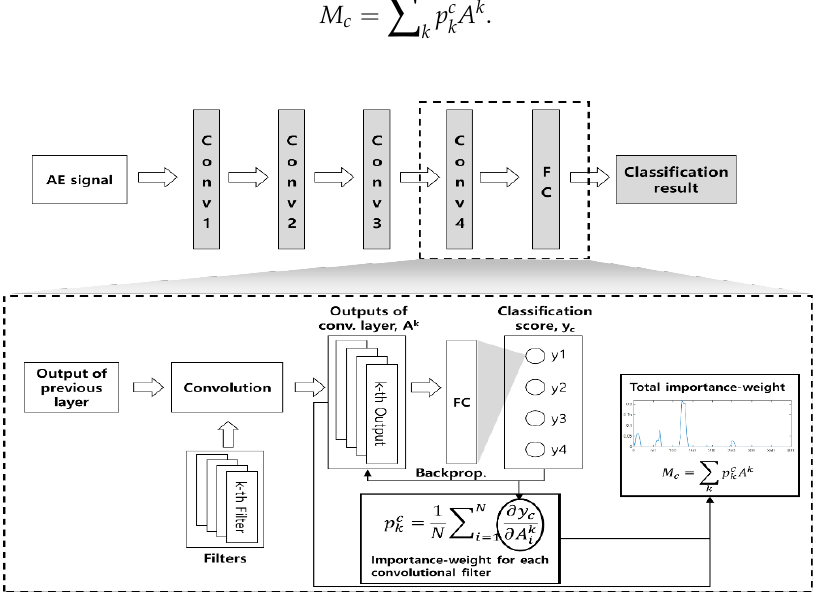
Figure 6. The flowchart of gradient-weighted class activation mapping (Grad-CAM) with an example of the CNN structure.